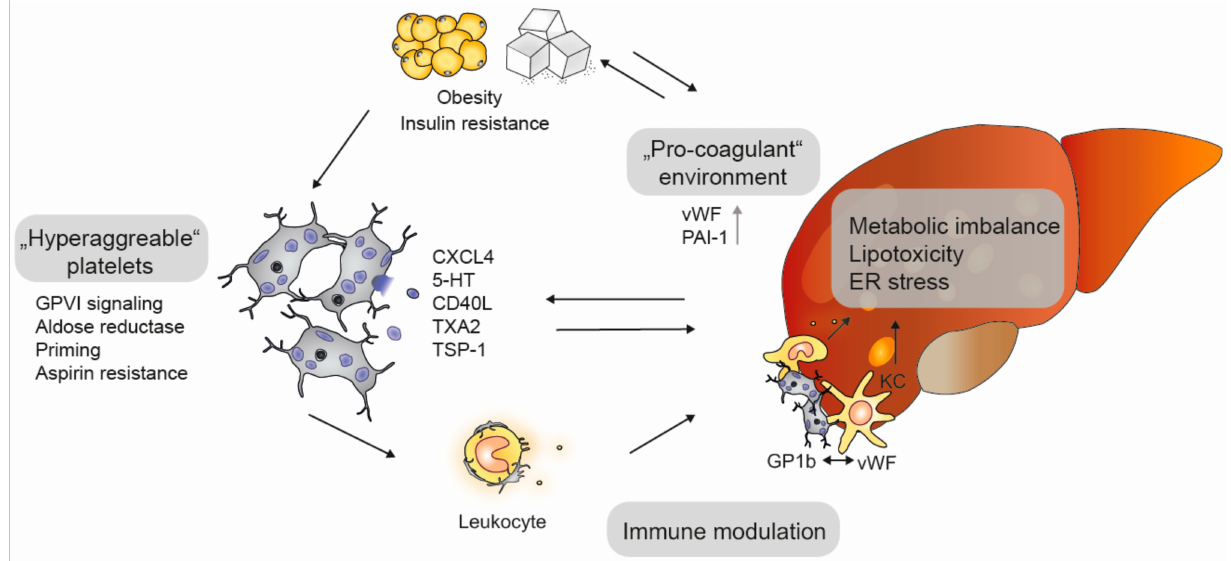
Figure 3. Platelets in non-alcoholic fatty liver disease (NAFLD). Obesity and insulin resistance promote the development of NAFL, which leads to a pro-coagulant state (e.g., increased von Willebrand factor [vWF] and plasminogen activator inhibitor [PAI-1]) and hyperaggregable platelets (e.g., elevated GPVI signaling, aldolase activity, platelet priming and aspirin resistance). The interaction with leukocytes and the release of granule content by activated platelets either promote (CD40 ligand [CD40L], chemokine (C-X-C motif) ligand [CXCL4] and serotonin [5-HT], thromboxane A2 [TxA2]) or prevent (thrombospondin-1 [TSP-1]) NAFLD